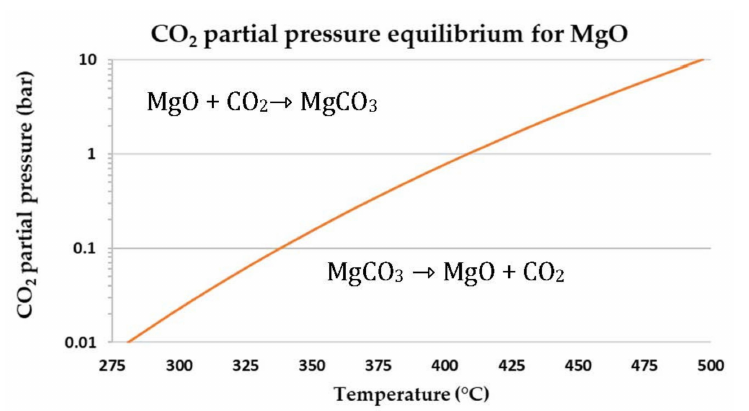
Figure 18. MgCO 3 equilibrium curve relating the temperature to the CO 2 partial